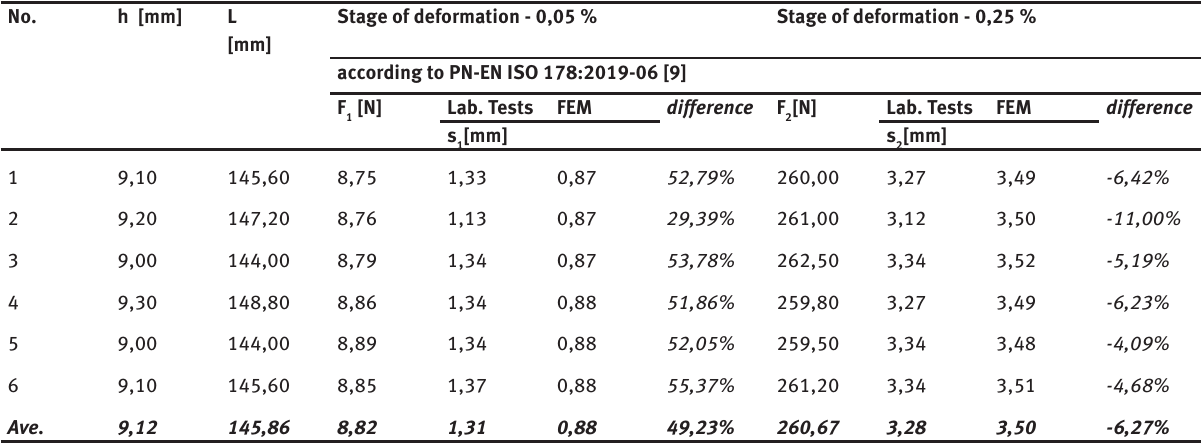
Table 9: Comparison of results of numerical analyses and laboratory tests for a model of a liner with a diameter of 350mm and 9,00mm wall thickness.